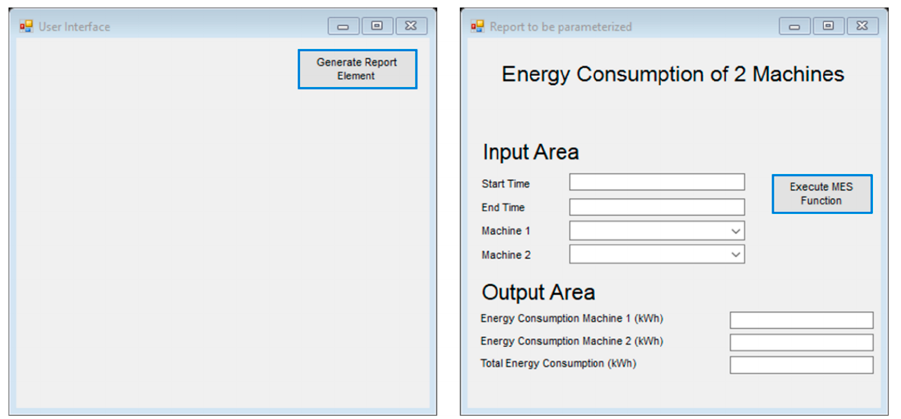
Figure 14. User interface of the generator ( left ) and the generated report to be parameterized ( right ).